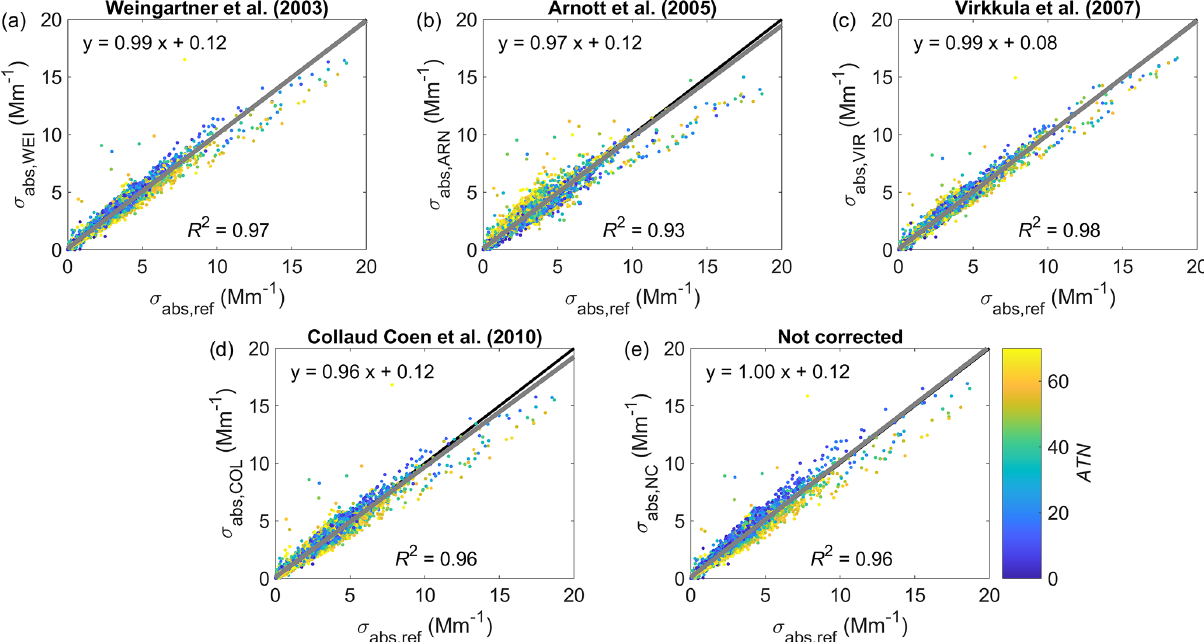
Figure 4. Comparison of the AE31 and MAAP measurements for all the different AE31 correction algorithms. The corrected AE31 data have been interpolated to the same wavelength as that of the MAAP (637nm). The data points are colored by the AE31 filter attenuation (ATN; at 660nm). The fit to the data is presented with a grey line, and the equation and the coefficient of determination ( R 2 ) are shown in the panels. The 1:1 line is shown in